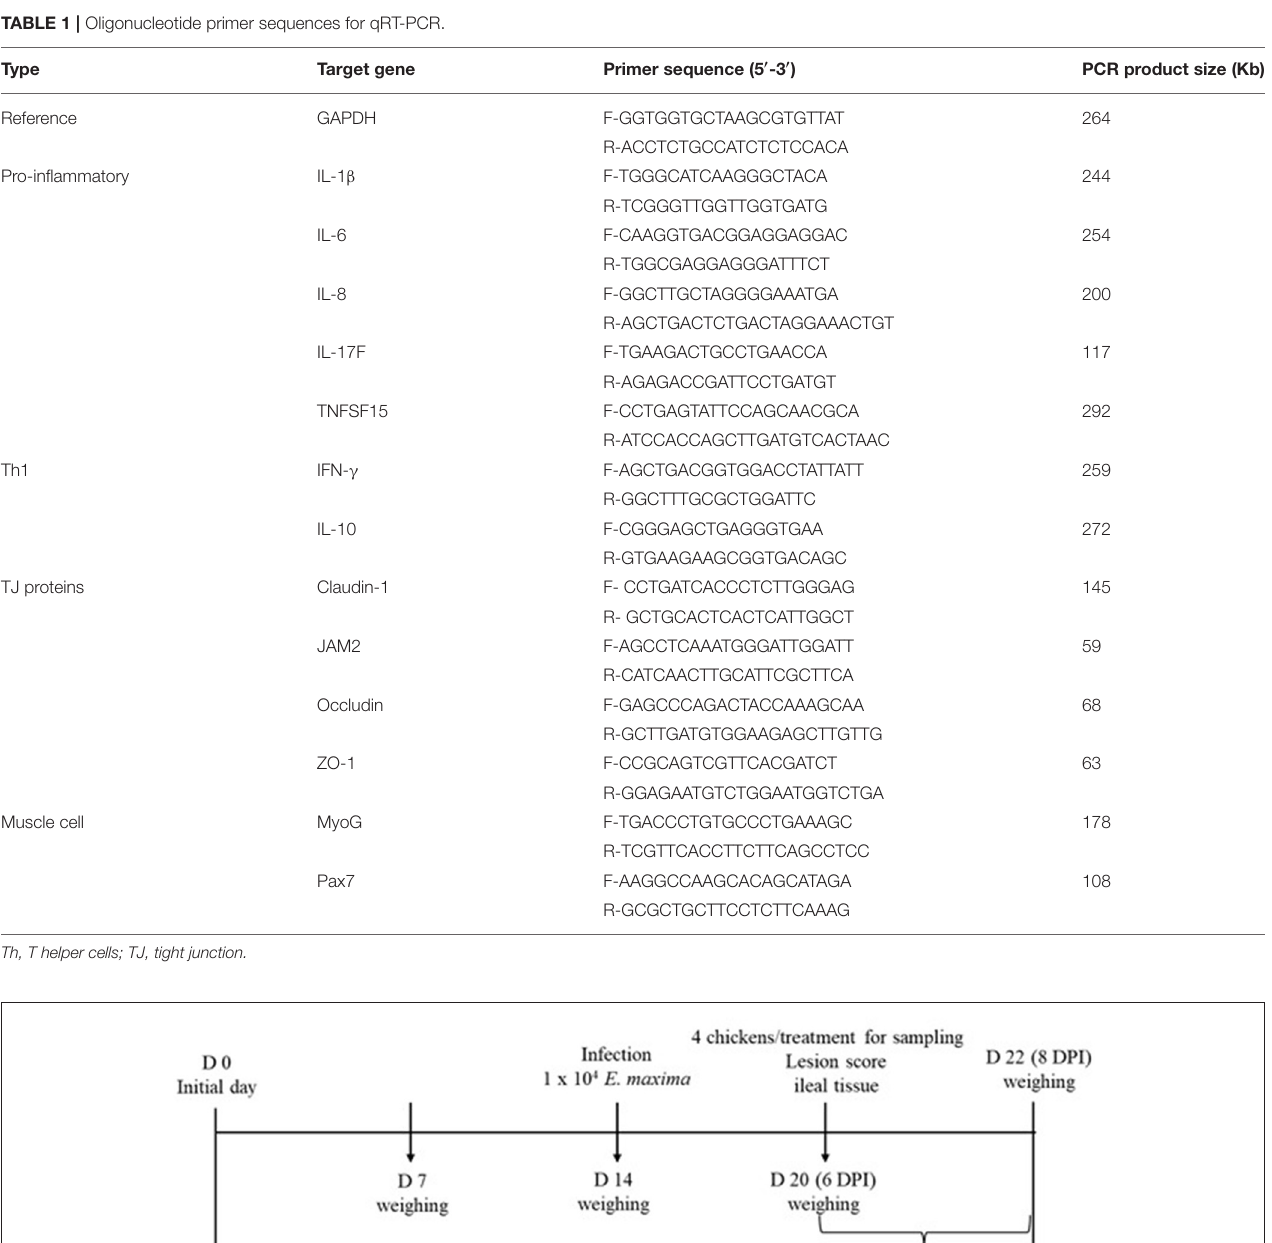
observers in a blinded manner, as per methods described previously